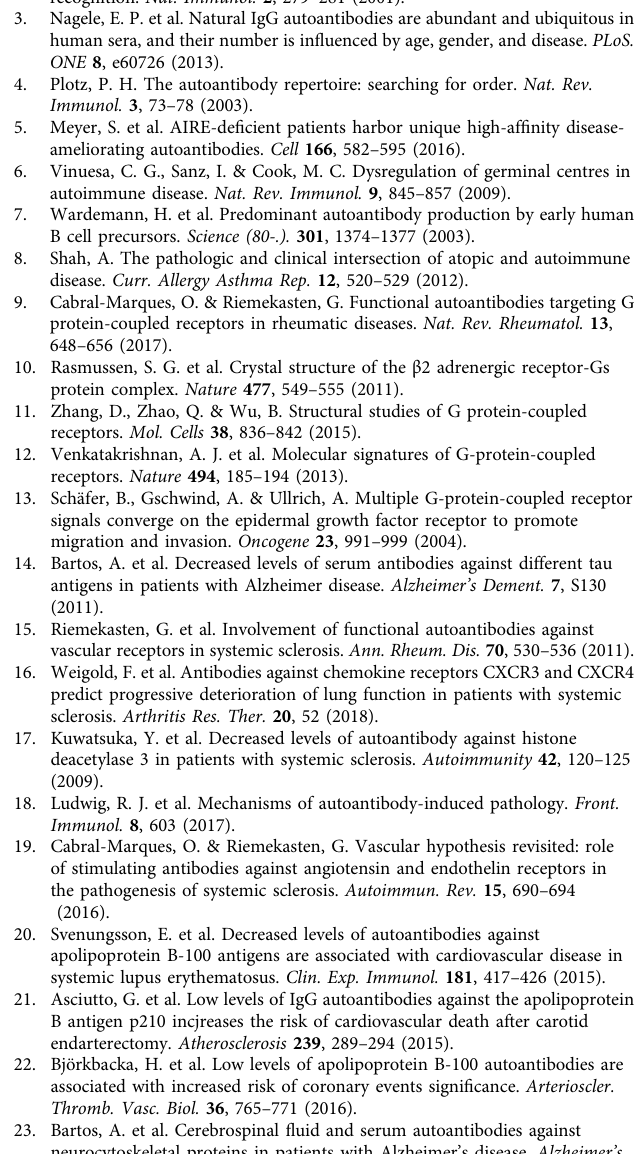
Fig. 8 Effect of HD-IgG and anti-EDNRA autoantibodies on neutrophil migration. a Expression of endothelin receptor type A (EDNRA) by human neutrophils ( n = 16). The fl uorescence minus one control (FMO) was analyzed as shown in Supplementary Figure 5. b Neutrophil chemotaxis